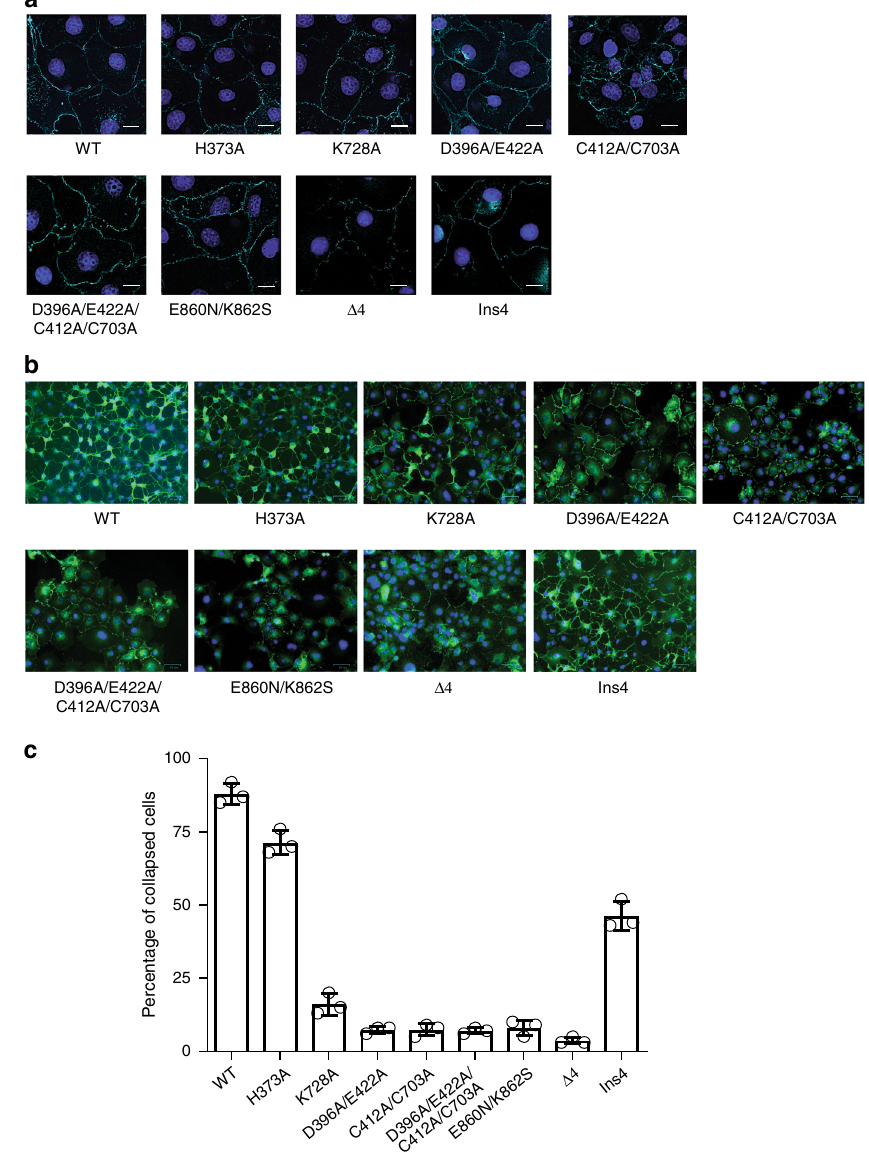
Fig. 5 Functional analyses of the inter-domain interactions in PlexinC1 using the COS-7 cell collapse assay. a Binding of A39R to PlexinC1 wild type or mutants expressed in COS-7 cells. Cells were treated with His 8 -tagged A39R at 50 nM for 10 minutes, fi xed and subjected to immunostaining with an anti- His-tag antibody. Cells did not undergo collapse after this short period of A39R treatment, therefore suitable for assessing cell surface expression and A39R binding of PlexinC1. A39R and the nucleus are pseudo-colored green and blue, respectively. Δ 4, deletion of four residues (938 – 941) in the linker between the IPT4 and TM of PlexinC1. Ins4, insertion of four residues (GSSG) between residues 939 and 940. Scale bar, 15 µ m. One representative image from three biological repeats is shown for each group. b A39R-induced collapse of COS-7 cells expressing PlexinC1 wild type or various mutants. Cells were treated A39R at 50 nM for 90 minutes. FLAG-tagged PlexinC1 was visualized through immunostaining with anti-FLAG antibody and Alexa Fluor 488- labelled anti-mouse IgG secondary antibody. PlexinC1 and the nucleus are pseudo-colored green and blue, respectively. One representative image from three biological repeats is shown for each group. c Quanti fi cation of the results from ( b ). The individual data points, mean and s.e.m of cell collapse percentage from three biological repeats are shown. In total, 96 – 147 cells in each sample were counted in each of the three biological repeats. Source data are provided as a source data fi